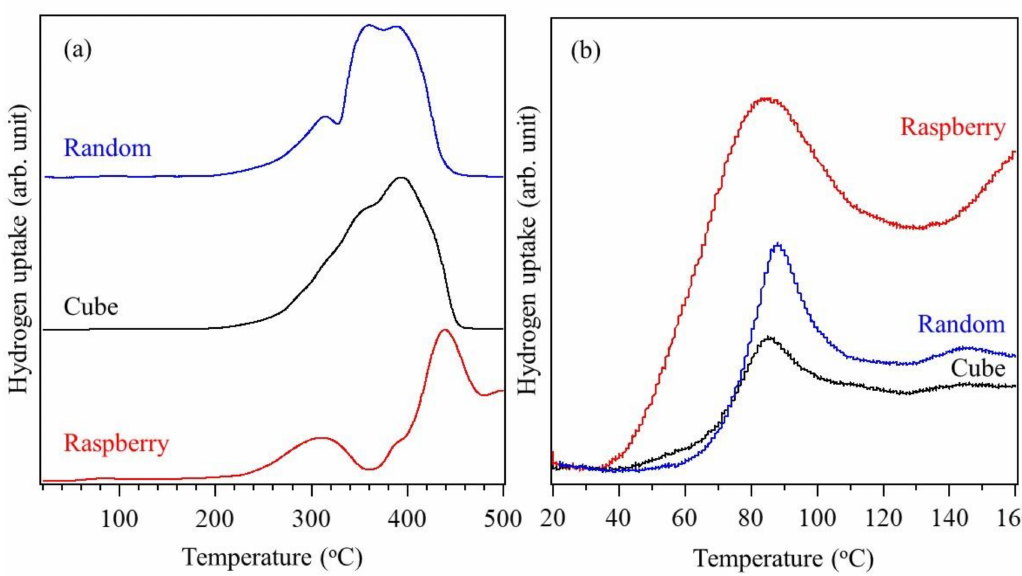
Figure 7. ( a ) H 2 -TPR curves of randomly shaped (blue), cube-shaped (black), and raspberry-shaped (red) Co 3 O 4 nanoparticles; ( b ) Enlarged view of the H 2 -TPR curves in the temperature range of 20–160 ◦ C.